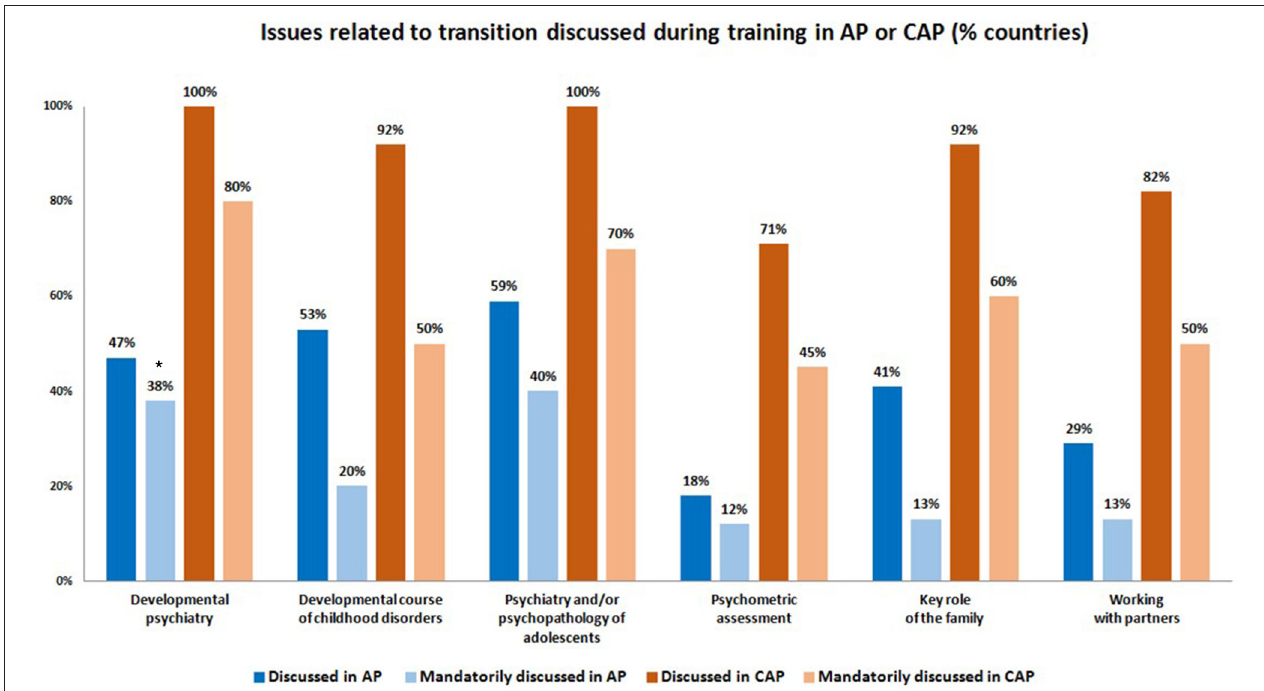
FIGURE 2 | Issues related to transition discussed in AP and CAP training. (*) % mandatory = number of countries answering “yes” if an issue was mandatorily discussed / (number of countries responding to the question about the corresponding issue being discussed or not–number of non-responding countries to